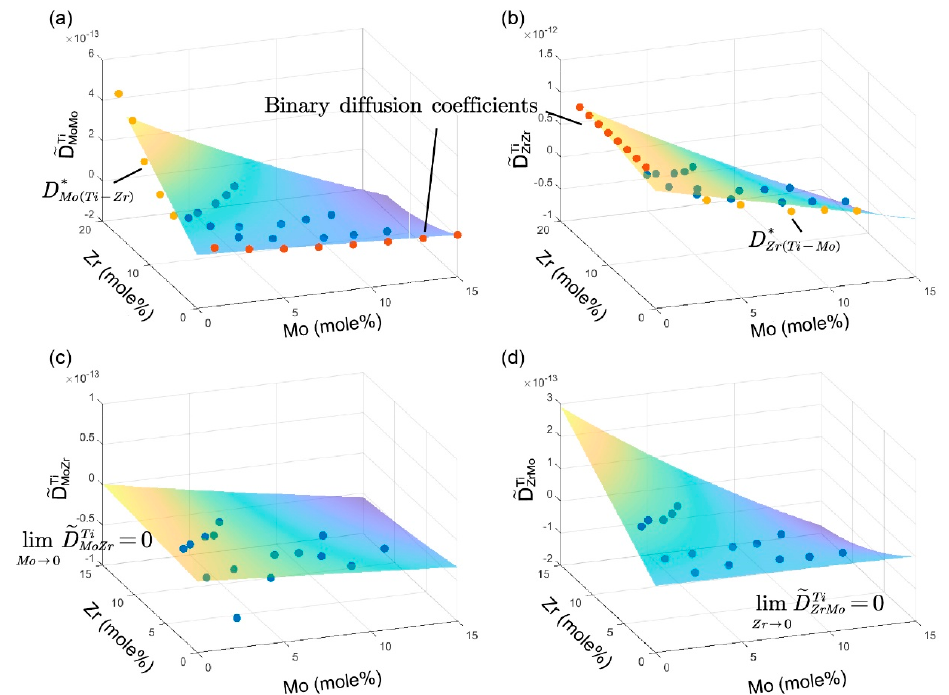
 Ti D  Ti , ( b ) (cid:101) D Ti , D MoMo MoMo ZrZr MoMo